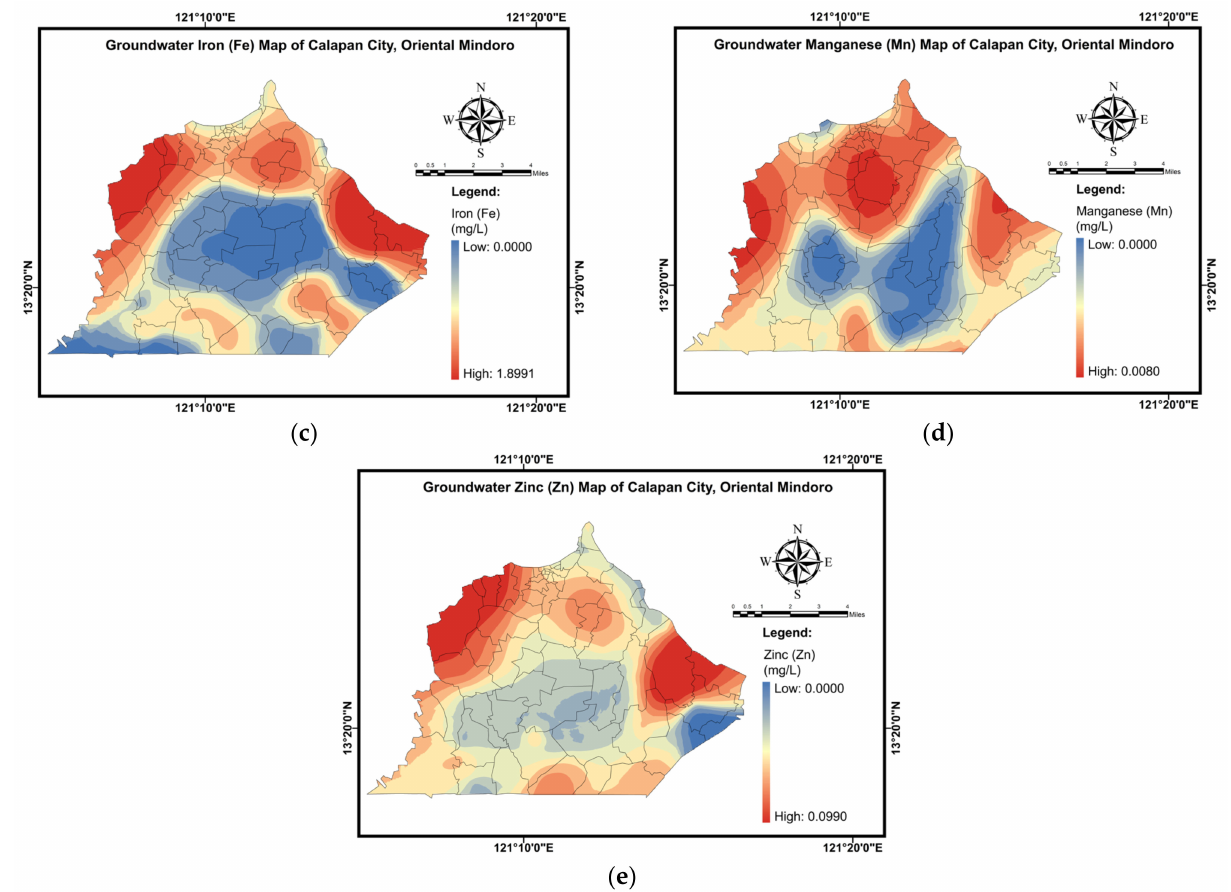
Figure 11. Heavy metal concentration map of Calapan City ( a ) Ba, ( b ) Cu, ( c ) Fe, ( d ) Mn, and ( e )